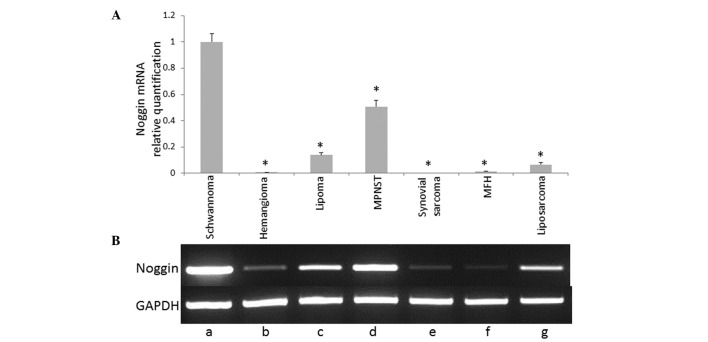
Noggin mRNA expression in soft tissue tumors. (A) Quantitative PCR analysis was performed on total RNA isolated from the schwannoma, hemangioma, lipoma, MPNST, synovial sarcoma, MFH and liposarcoma soft tissue tumors (n=5). Gene expression was normalized to GAPDH expression. Data are presented as expression relative to the control (schwannoma). Values are presented as the mean ± standard deviation. (B) Expression of noggin mRNA detected using reverse transcription PCR analysis. *P<0.05 vs. the control. MPNST, malignant peripheral nerve sheath tumor; MFH, malignant fibrous histiocytoma; PCR, polymerase chain reaction.